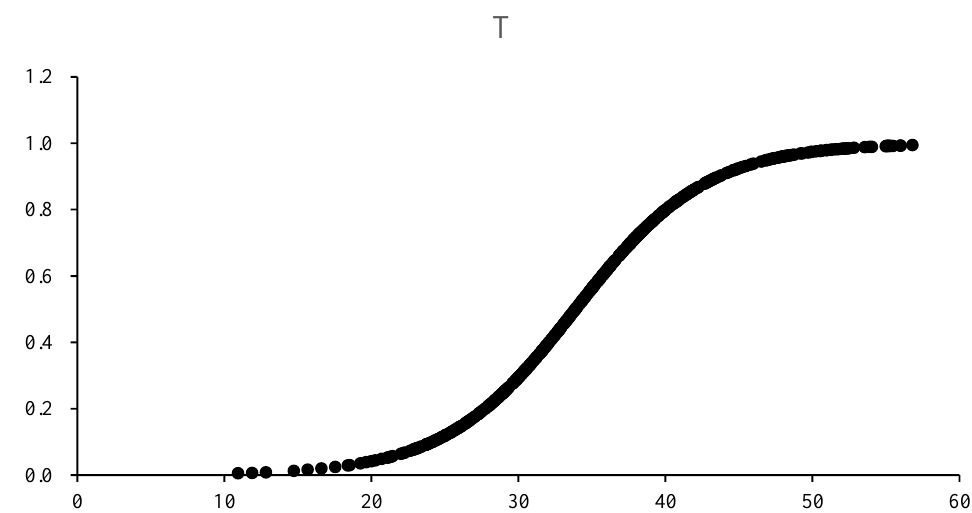
Figure 2. The transfer function image of technological innovation.